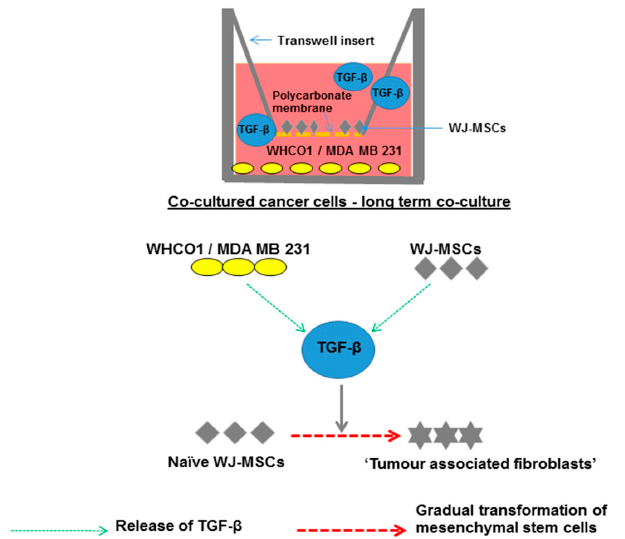
Figure 4. WHCO1, MDA MB 231 cells and MSCs secrete TGF- β . Mesenchymal stem cells (5 × 10 5 cells) were cultured in the upper insert and cancer cells (WHCO1 and MDA MB 231) (5 × 10 5 cells) were